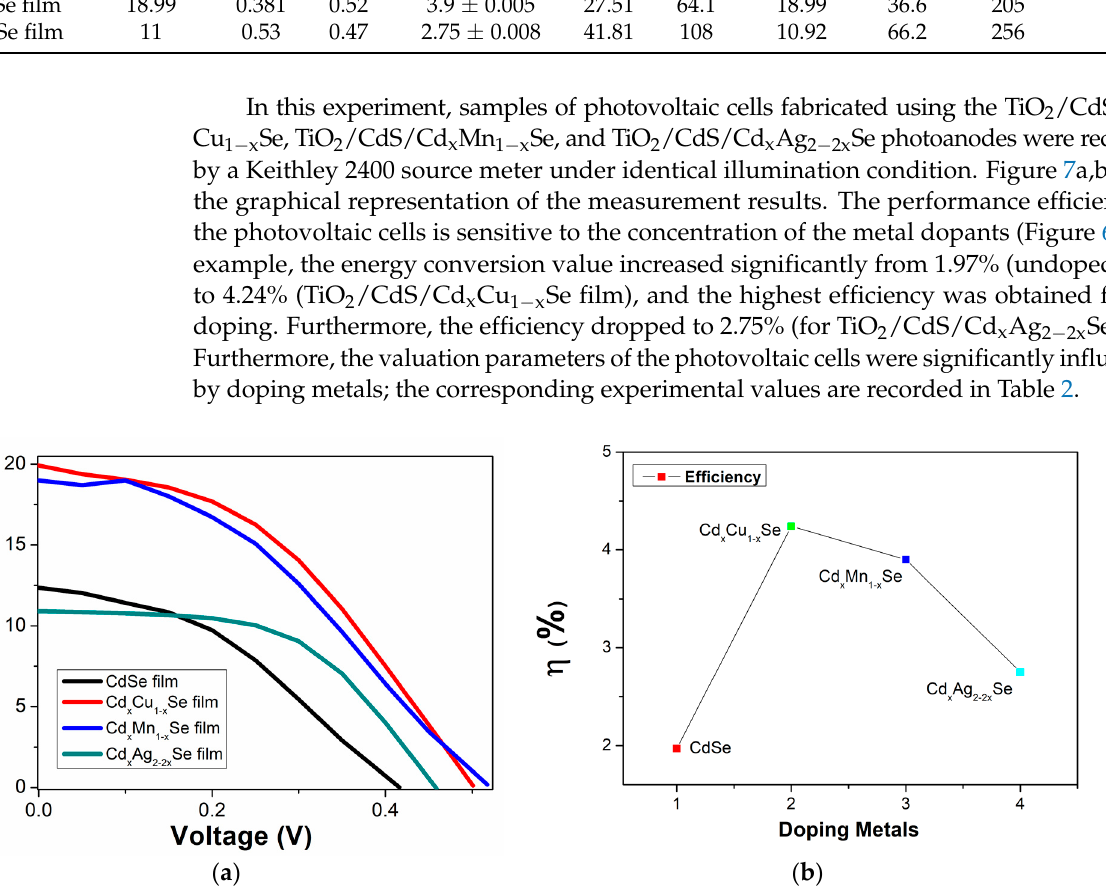
Figure 7. ( a ) Variation of photocurrent density–voltage curves and ( b ) dependence of the performance efficiency on metal addition in films.